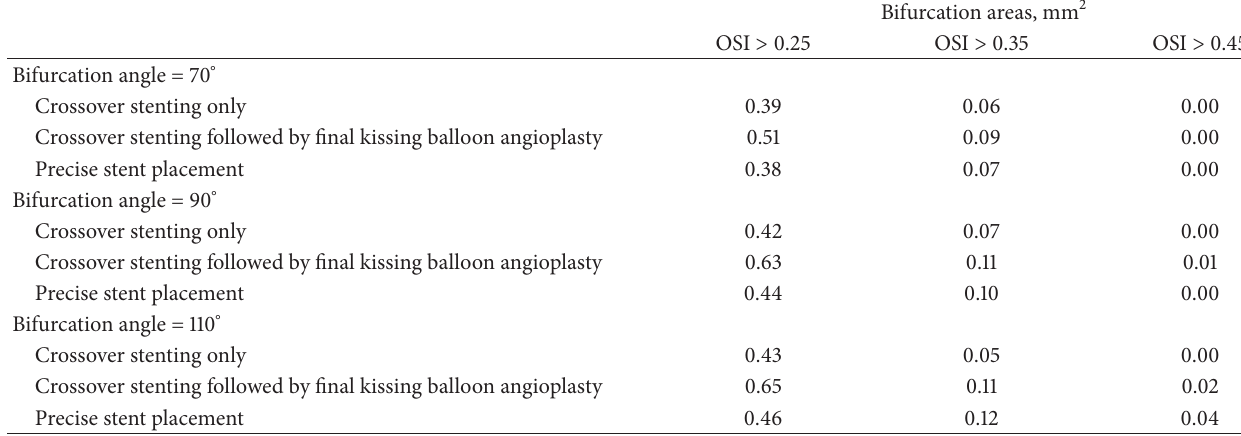
Table 3: Bifurcation area subjected to OSI specific thresholds for considered stenting techniques under different bifurcation angle